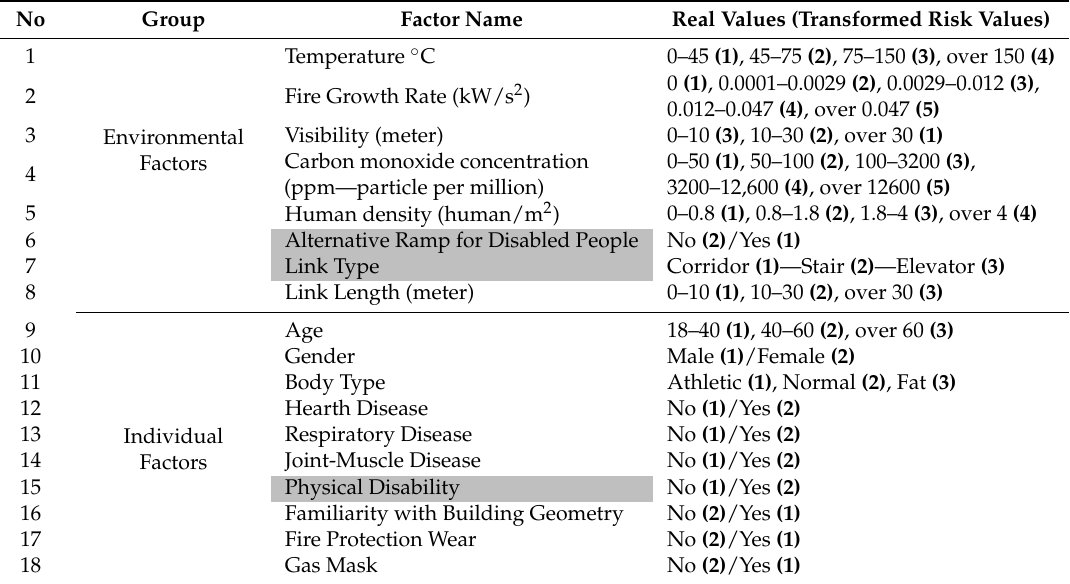
Table 1. Factors used for the ANN